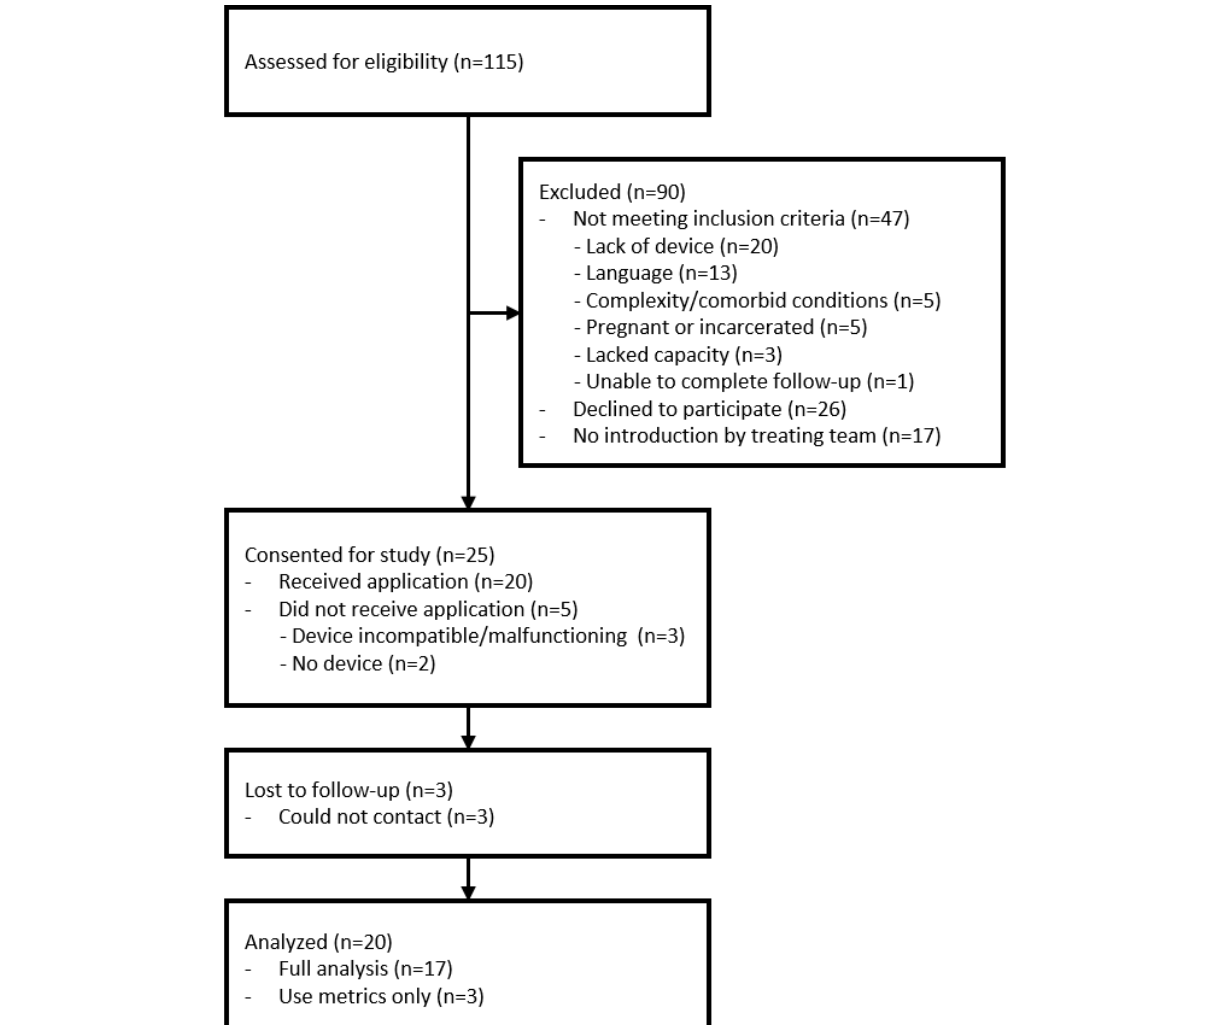
Figure 1. Patient screening and